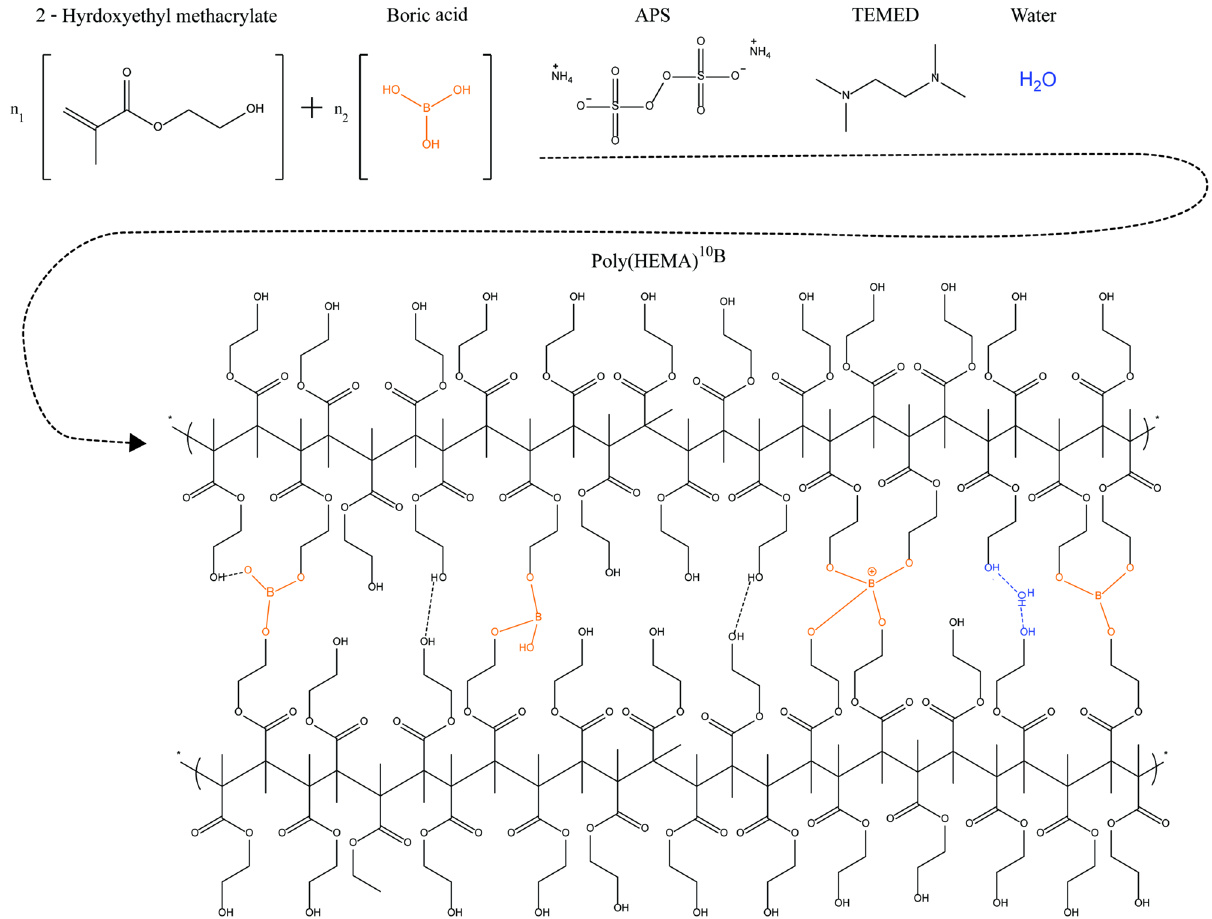
Figure 1. Reaction scheme of the new material.